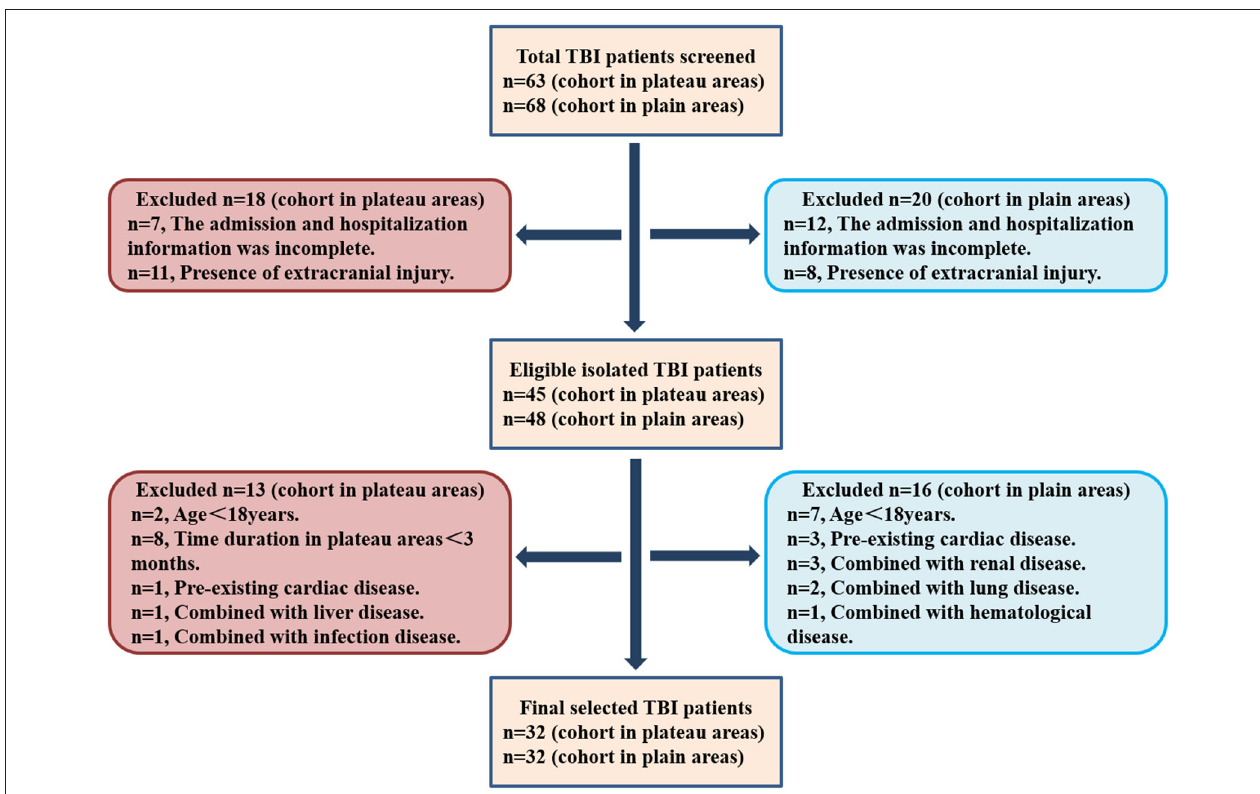
FIGURE 1 | The selection flowchart of patients with traumatic brain injury (TBI) in plateau and plain